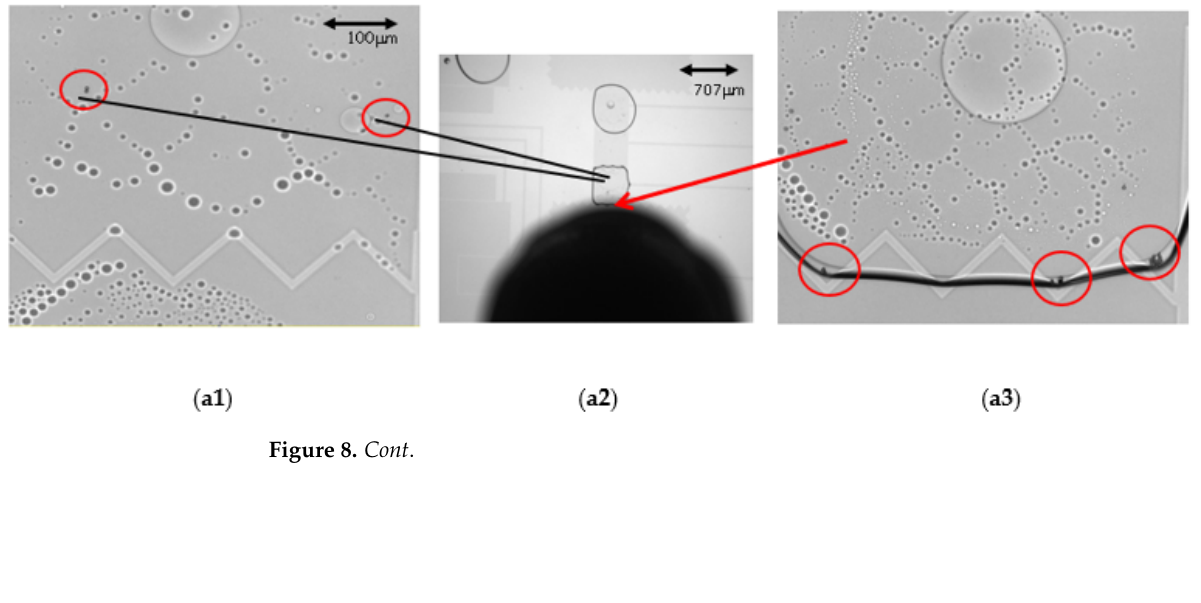
Figure 8. Beads aggregation issue with too few or too many beads. ( a ) 25 magnetic beads : ( a1 ) Some magnetic beads cannot be aggregated; ( a2 ) The droplet with 25 magnetic beads, black shadow was the magnet; ( a3 ) Some magnetic beads could not be aggregated. ( b ) More than 500 magnetic beads: ( b1 ) Some magnetic beads were stuck and could not be moved; ( b2 ) The droplet with more than 500 beads; ( b3 ) Some successfully aggregated beads. 4. Conclusions In this study, bead-screening chips were successfully developed to quantify the re- quired magnetic beads. By fixing 100, 49, or 25 magnetic beads, the fluorescence intensity of the human IL-1 β samples were measured with concentrations at 0 pg/mL, 0.1 pg/mL, 1 pg/mL, 10 pg/mL, 25 pg/mL, 50 pg/mL, 75 pg/mL, and 100 pg/mL to establish four com- posite calibration curves. Compared to the unfixed number of beads (50–160), with the sample size of three at each concentration in all four calibration curves, there was a signif- icant decrease in the CVs for the fixed number of magnetic beads. Among the three dif- ferent numbers of fixed magnetic beads, the CV values for 100 beads were best. In the range of 1.0 pg/mL to 100 pg/mL, the CVs for 100 beads were all less than 10%. When the number of beads was not fixed, the fluorescence intensity distribution at different concen- trations may have overlapped, while there was no overlapping area with a fixed number of beads. Furthermore, the calculated LOD based on the composite calibration curves could be reduced by three orders, from 3.0 pg/mL (for the unfixed number of beads) to 0.0287 pg/mL (for 100 beads). When there were 25 magnetic beads, the magnetic beads sometimes could not be ag- gregated properly due to insufficient magnetic force. When the number was more than 500, the magnetic beads easily became stuck and hard to move for complete aggregation.